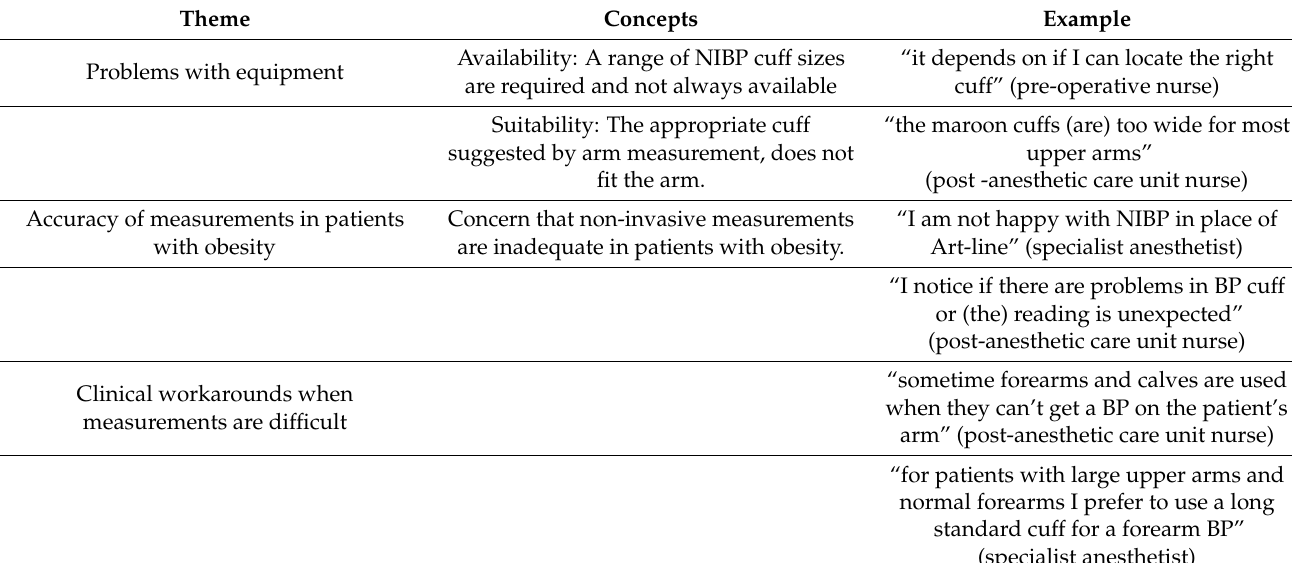
Table 6. Results of conventional content analysis, responses from 20 staff concerning the implementation of NIBP cuff selection based on arm measurement. Pre-operative nurses: 2; intraoperative specialist anesthetists: 10; post-anesthetic care unit nurses: